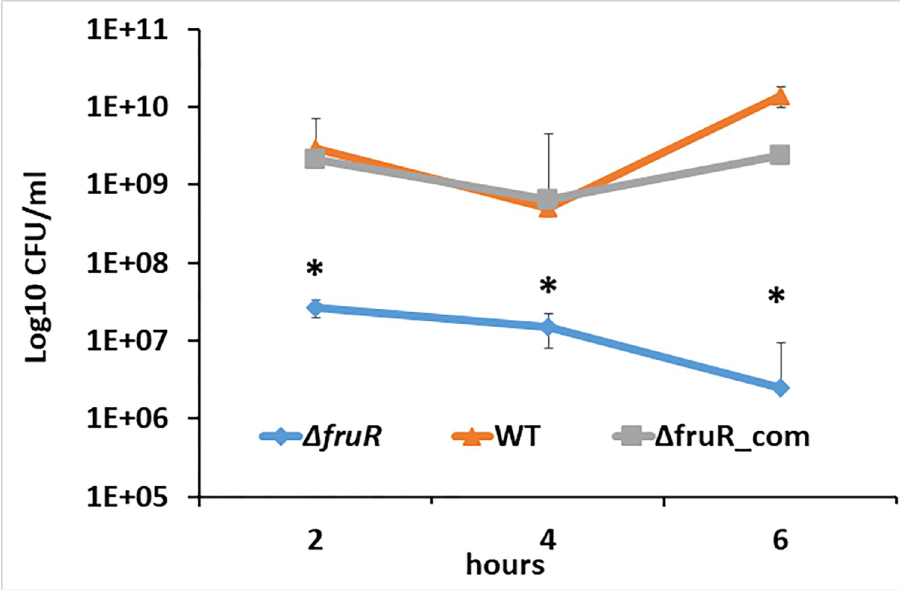
Fig 3. Intracellular replication of wildtype L . monocytogenes and Δ fruR . J774A.1 macrophage cells were infected with Δ fruR , wildtype (WT), and complemented Δ fruR ( Δ fruR _com). After infection, monolayers were washed, and medium containing gentamicin was added. At 2-, 4-, and 6-hours post-infection, macrophages were lysed, and released intracellular bacteria were quantified by determining CFU/ml in the lysate on BHI agar plates. All infections were performed in five replicates, and two independent assays were performed. The statistical significance between Δ fru R and wildtype at each indicated time point was determined using a student t test. Asterisks indicate statistical significance, with P <